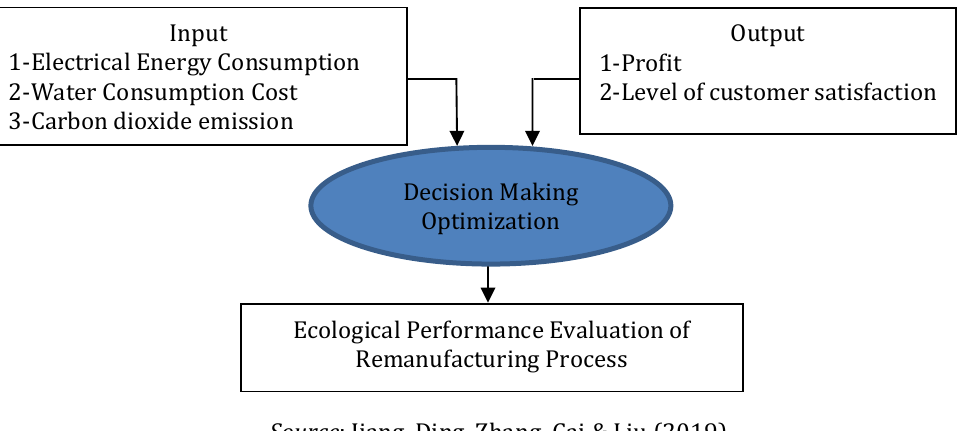
Source : Jiang, Ding, Zhang, Cai & Liu (2019)